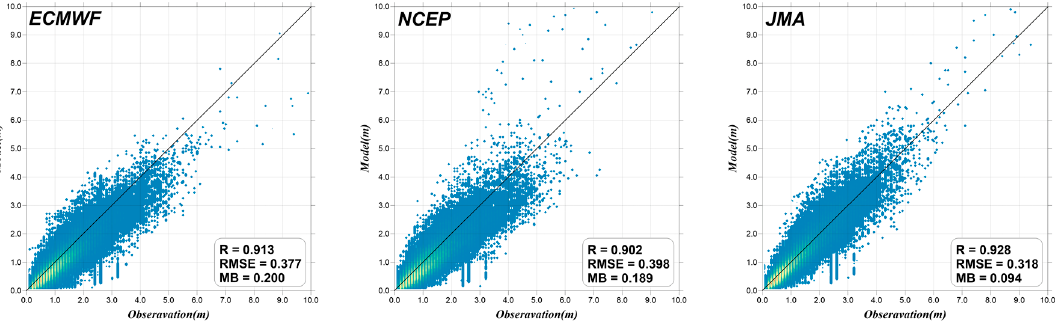
Figure 5. Scatter diagrams of measured and hindcasted significant wave heights around the Korean Peninsula over 2007–2018.